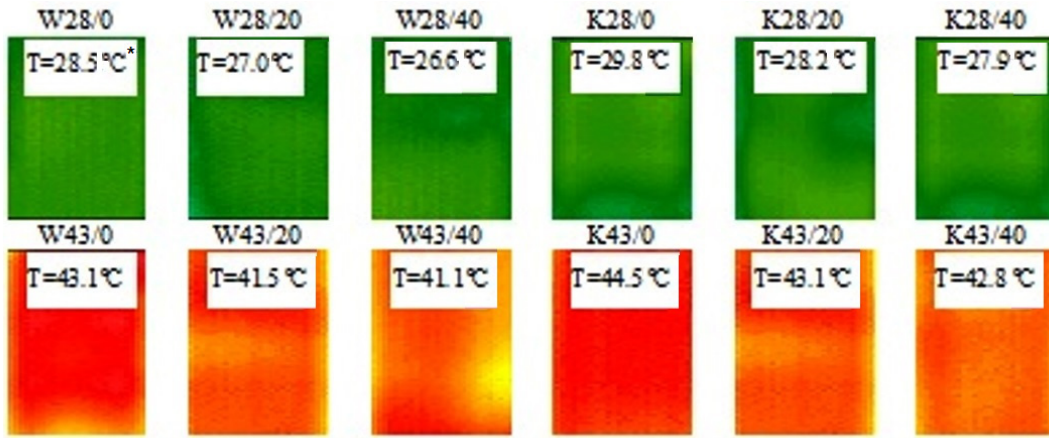
Figure 4. Thermograms of heating process recorded for W28 fabric in 120s and W43 in 270s and for K28 recorded in 110s and K43 in 270s (* average surface temperature of the sample).